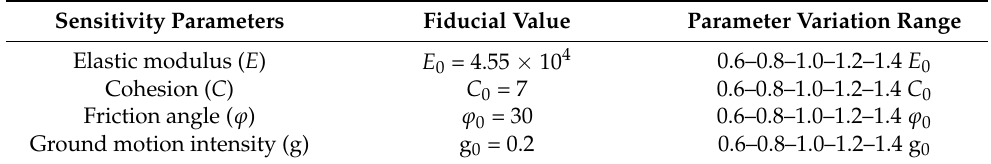
Table 2. Variable distribution. Sensitivity